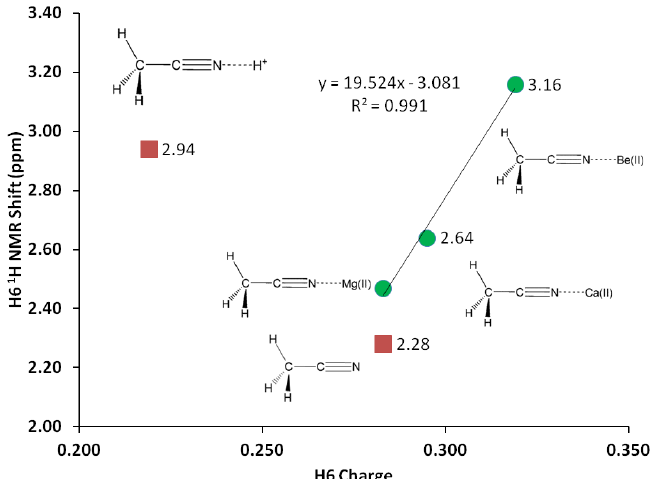
Figure 4. H6 1 H-NMR shift versus H6 charge (G3,